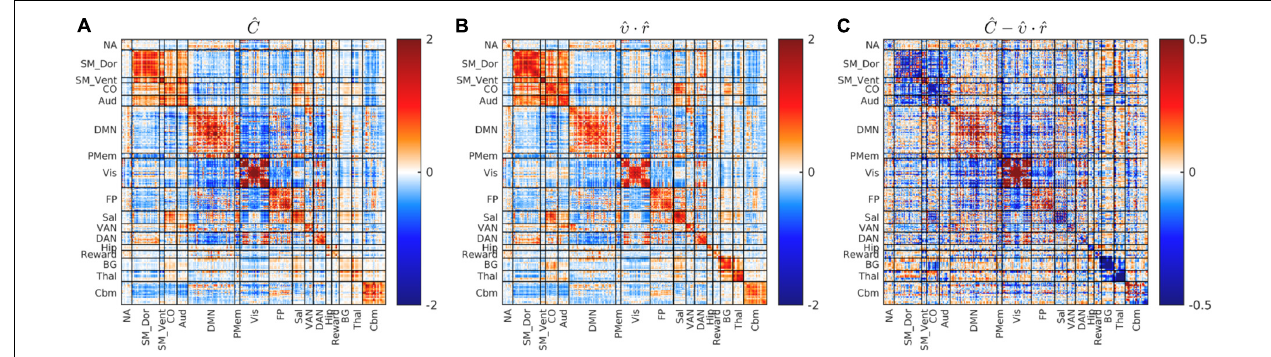
FIGURE 4 | Global blockwise scalar proportionality between the cohort-mean covariance and correlation matrices. (A) shows ˆ C . (B) Shows υ · ˆ r . (C) Shows the difference, ˆ C − υ · ˆ r , on a scale of increased gain. Focal deviations from global blockwise scalar proportionality. These deviations account for only 13% of total variance. Scale change in (C)